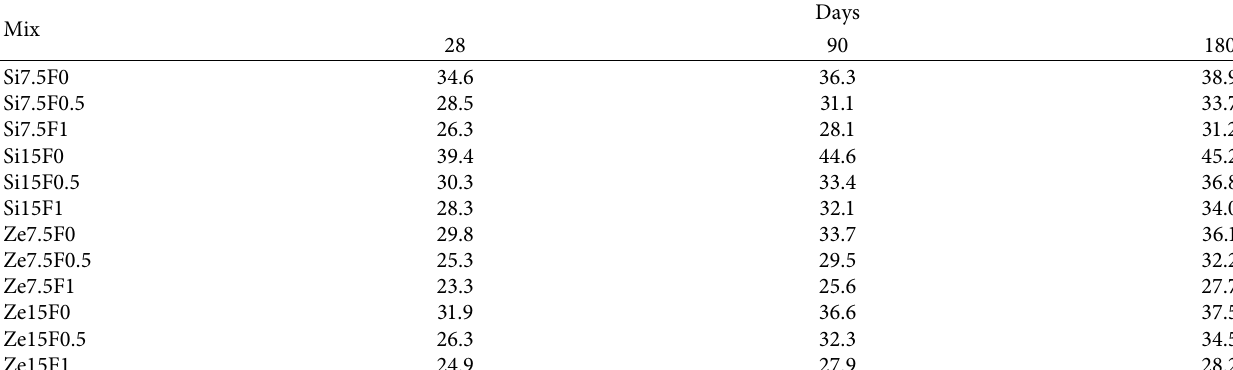
Table 7: Compressive strength results (MPa).